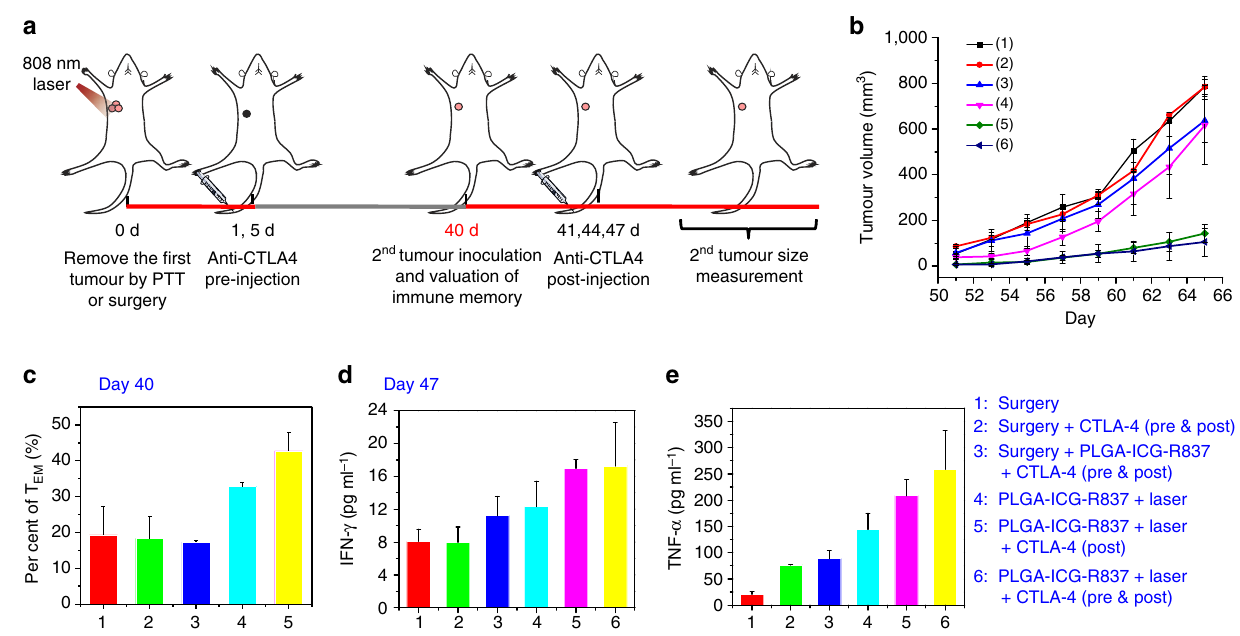
Figure 5 | Long-term immune-memory effects. ( a ) Schematic illustration of PLGA-ICG-R837-based PTTand anti-CTLA-4 combination therapy to inhibit cancer relapse. ( b ) tumour growth curves of rechallenged tumours inoculated 40 days post eliminated of their first tumours (eight mice per group). ( c ) Proportions of effector memory T cells (T EM ) in the spleen analysed by flow cytometry (gated on CD3 þ CD8 þ T cells) at day 40 right before rechallenging mice with secondary tumours (groups 4 and 5 would be identical at this point). ( d , e ) Cytokine levels in sera from mice isolated 7 days after mice were rechallenged with secondary tumours (after the second round of anti-CTLA4 treatment). Three mice were measured in each group in c – e . Data are presented as the mean ±